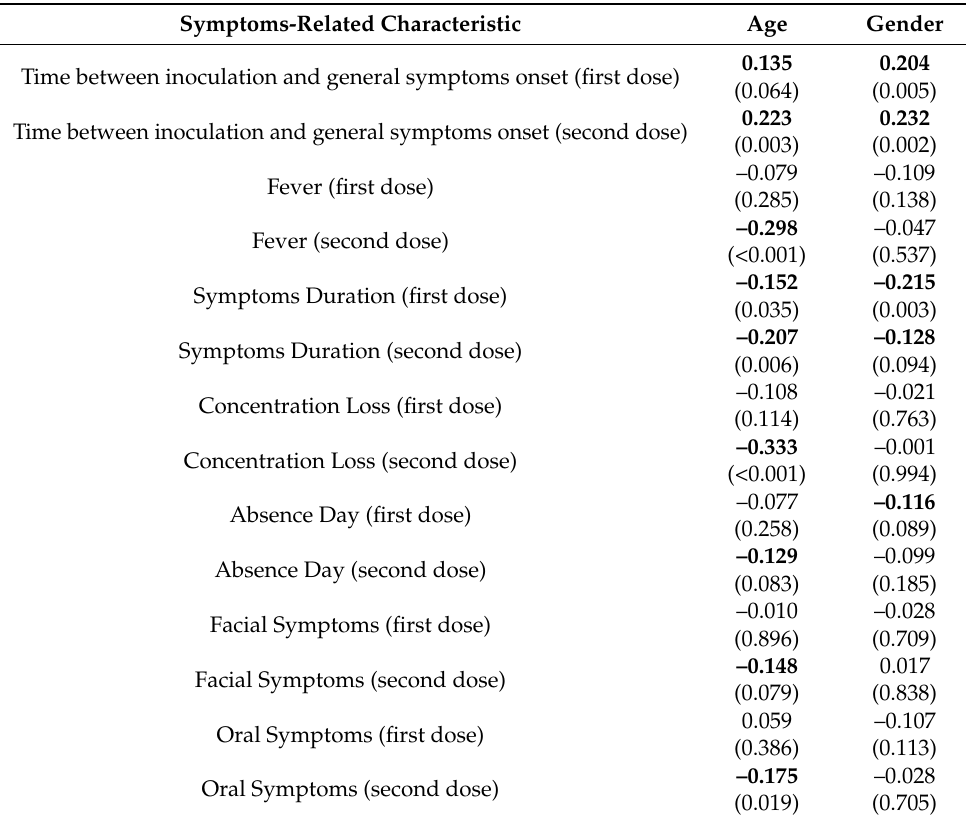
Table 4. Correlation coefficients. Significant values are in bold, p -values in parentheses. A positive value in the age column means that older people had higher expected values of the correspondent symptoms-related characteristic. A positive value in the gender column means that males had higher expected values of the correspondent symptoms-related